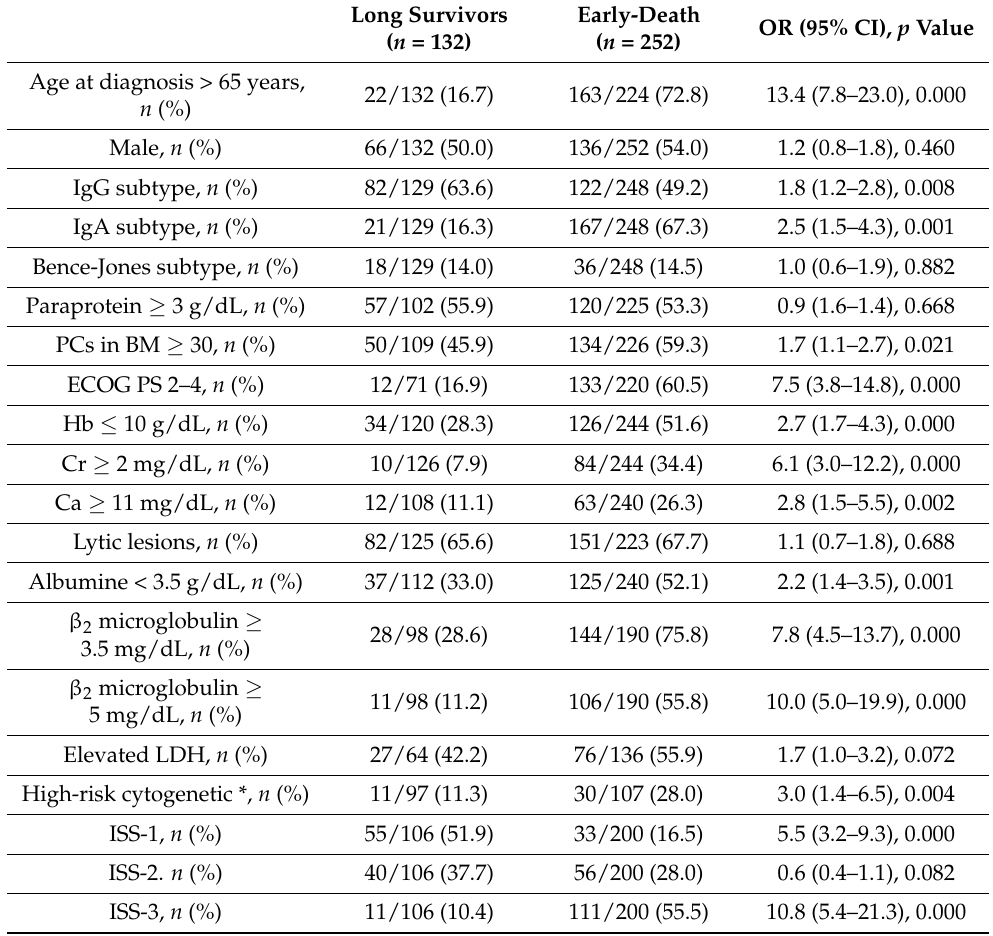
Table 3. Univariable analysis: long survivors vs. early death patients.